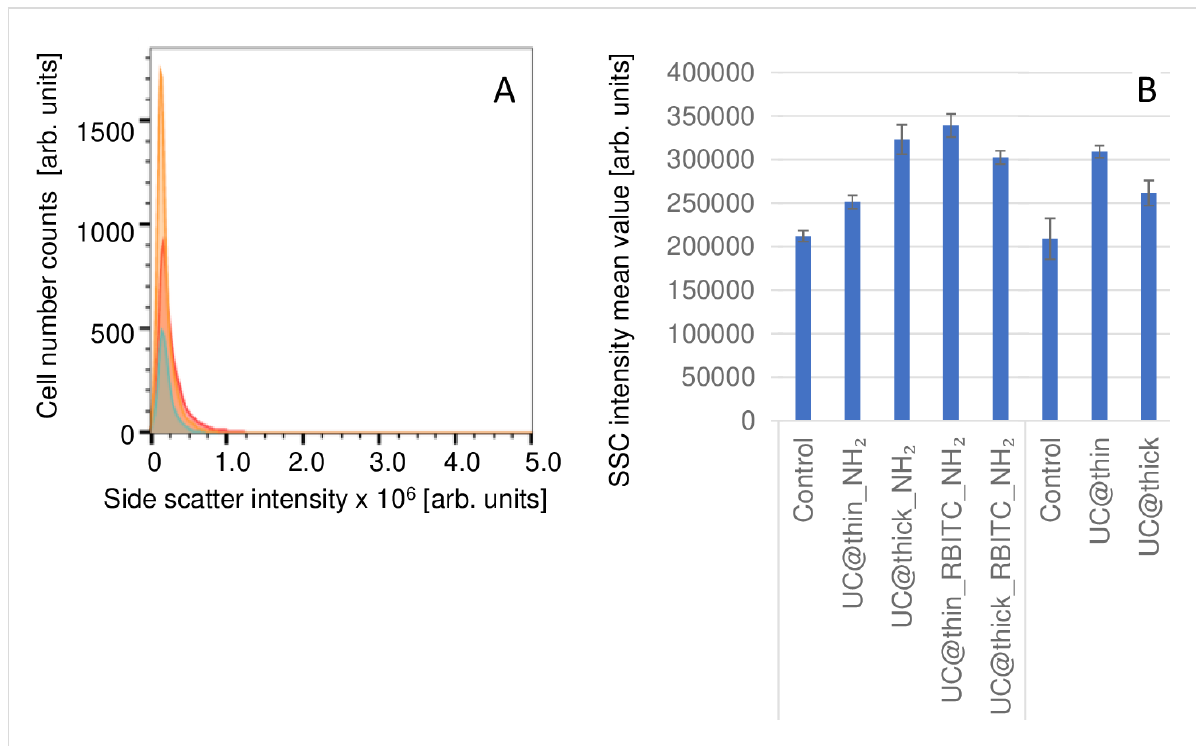
Figure 3: (A) SSC histograms of RAW 264.7 cells after particle exposure for 24 h at 37 °C. UC@thin_NH 2 is marked by a blue-framed peak, UC@thick_NH 2 is marked by a red-framed peak, and the control is marked by a yellow-framed peak. (B) Summary of mean SSC flow cytometry mea- surements on all samples in RAW 264.7 cells after particle exposure for 24 h at 37